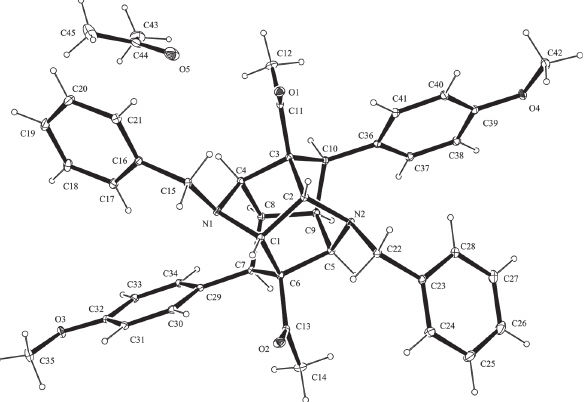
Table 2: Fractional atomic coordinates and isotropic or equivalent isotropic displacement parameters (Å 2